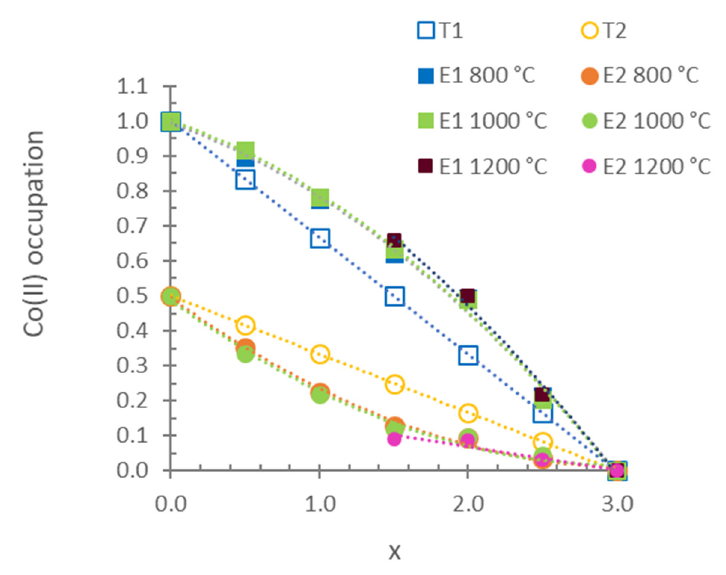
Figure 5. Variations in the occupation of Co(II) ions with composition in sites of the stable Co 3 P 2 O 8 structure from the fired Mg x Co 3 − x P 2 O 8 compositions. E1: experimental occupation in pentacoordi- nated sites (M1), E2: experimental occupation in octahedral sites (M2), T1: theoretical random occu- pation in M1 sites and T2: theoretical random occupation in M2 sites.